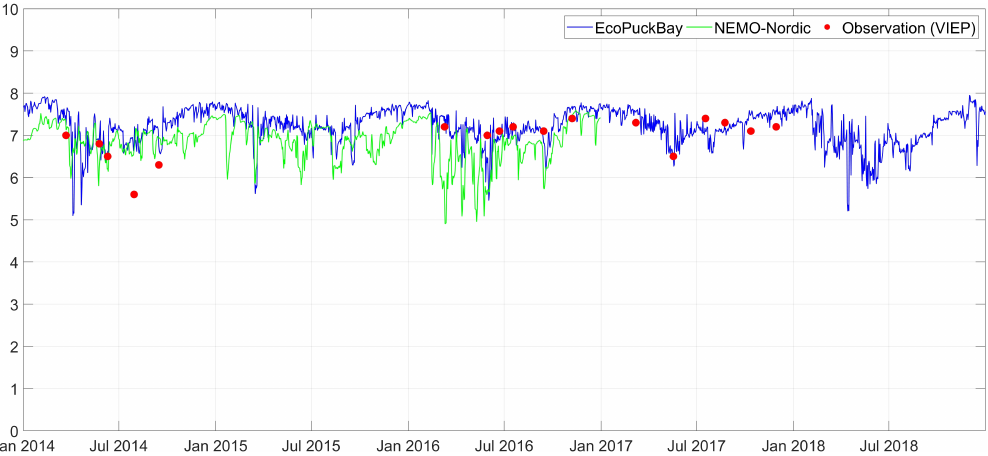
Figure A12. Time series of surface salinity on station T12 compared with VIEP observations and NEMO-Nordic model.